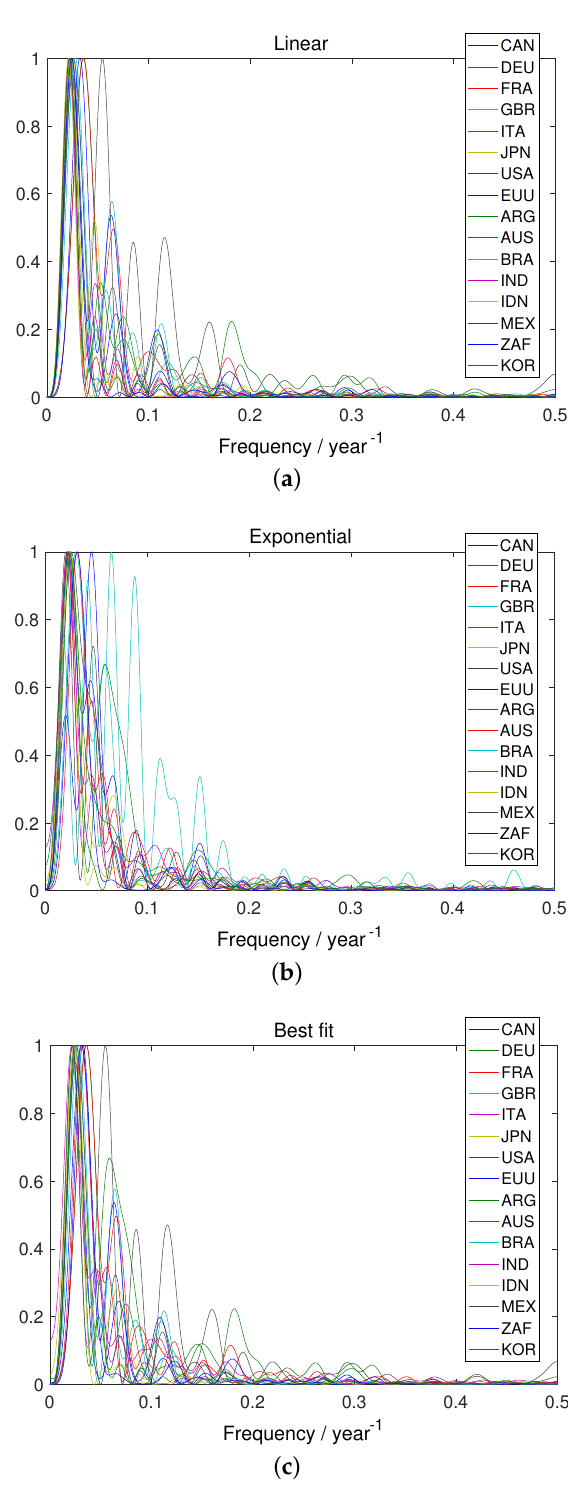
Figure 1. Spectral content of the oscillations y ( t ) − ˜ y ( t ) for all countries, normalized so that every curve has a peak with amplitude 1, where y ( t ) is the GDP, and ˜ y ( t ) is a trend line: ( a ) Linear tendency ( b ) Exponential tendency ( c ) The best of the previous